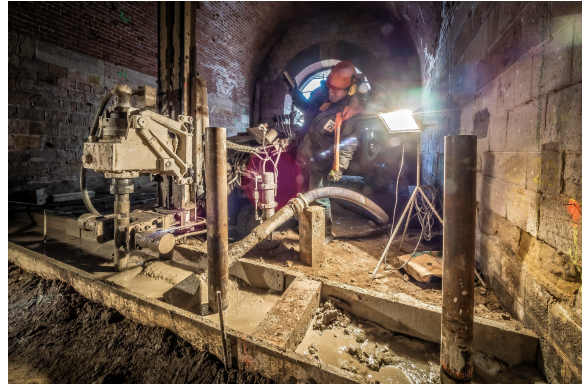
Figure 3. Special foundation works at the former custom